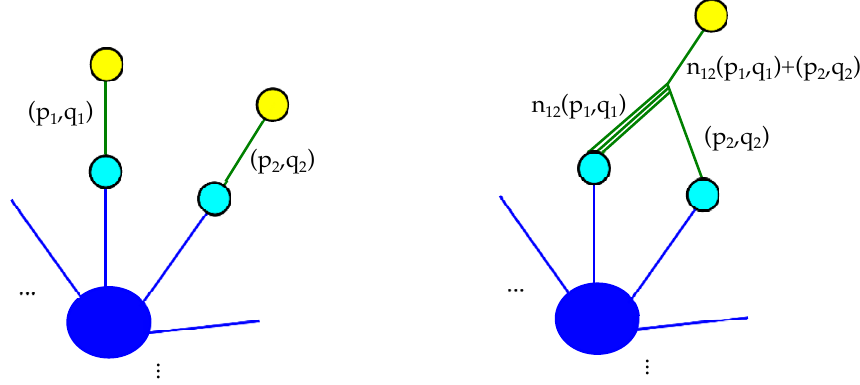
Figure 1 . On the left hand side is shown a general 5-brane web (blue) indicating the external ( p, q ) 5-branes, ending on 7-branes (cyan). From these emanate ( p, q ) -strings (green), that end on D3-branes (yellow). Given a pair of external 5-branes, the strings can only form a junction, if they satisfy (3.129). This is shown on the right hand side. The resulting string can be moved into the brane-web, by moving the D3-brane inside the web, and becomes a local operator. This is the screening of the Wilson lines by local operators, realized in the